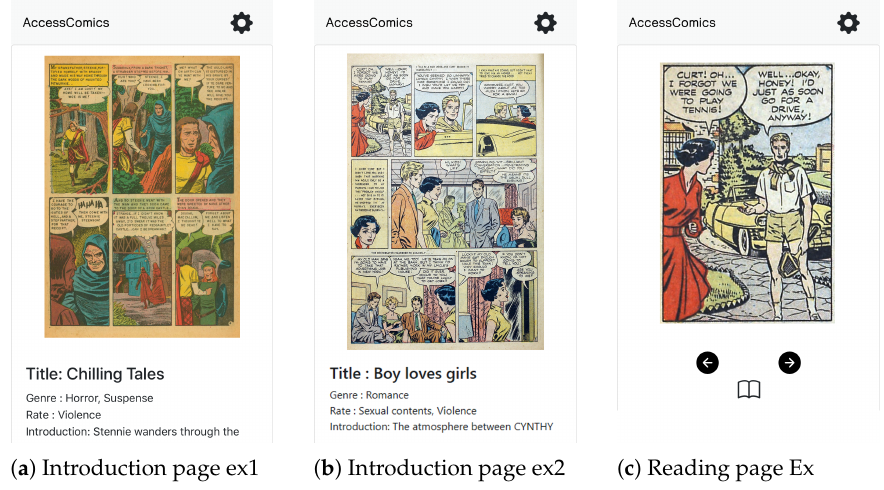
Figure 5. Solution and error progression curve for different times and ε values, with n = m = 40 and t max =